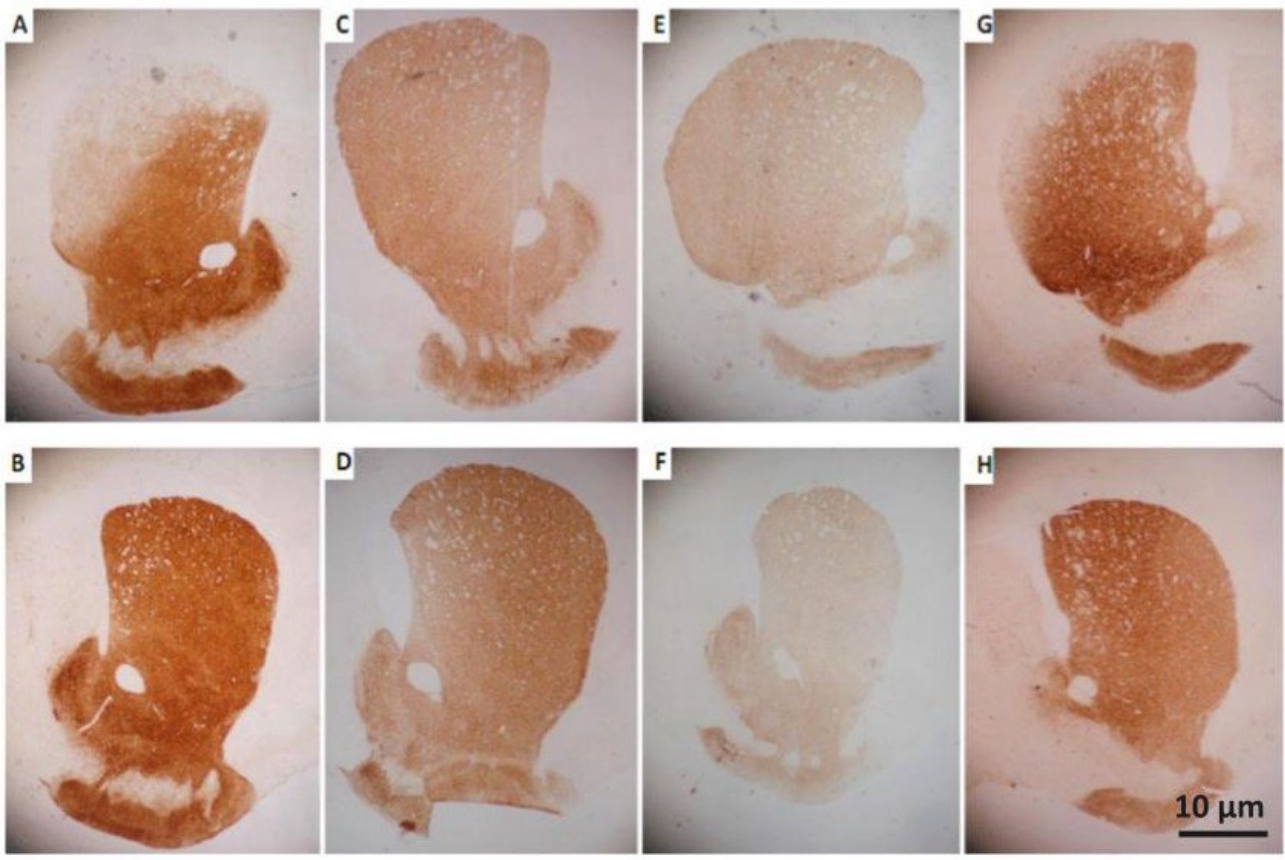
Figure 6. Representative photomicrographs of brain tissue in the dorsal striatum—CPu—after immunohistochemistry for TH. The images ( A ), ( C ), ( E ), ( G ) represent the injured sides, and the images ( B ), ( D ), ( F ), ( H ) represent their respective controls. In ( A , B ): group 6-OHDA/saline, ( C , D ): 6-OHDA/BV 0.01 mg·Kg −1 , ( E , F ): 6-OHDA/BV 0.05 mg·Kg −1 and ( G , H ): 6-OHDA/BV 0.1 mg·Kg −1 , referring respectively to microinjection intrastriatal and systemic treatment. Magnification of 40×.